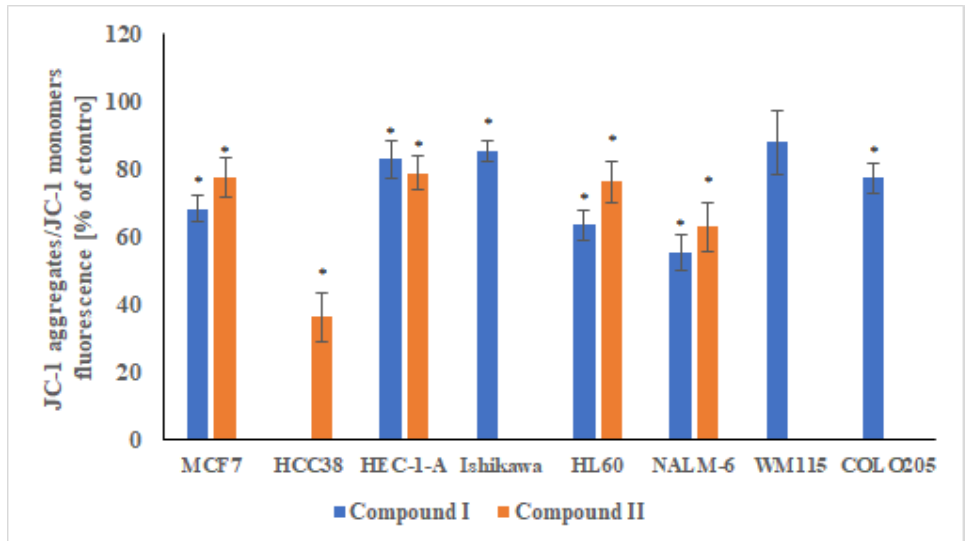
Figure 12. Changes in the mitochondrial potential of MCF7, HCC38, HEC-1-A, Ishikawa, COLO205, HL60, NALM-6, and WM115 cells exposed to compound I and II. Cells were incubated with derivatives for 24 h at concentrations of the calculated IC 50 . The results represent mean ± SEM of the data from 3 individual experiments, untreated control cells arbitrarily taken as 100%, * p < 0.05 vs. control.